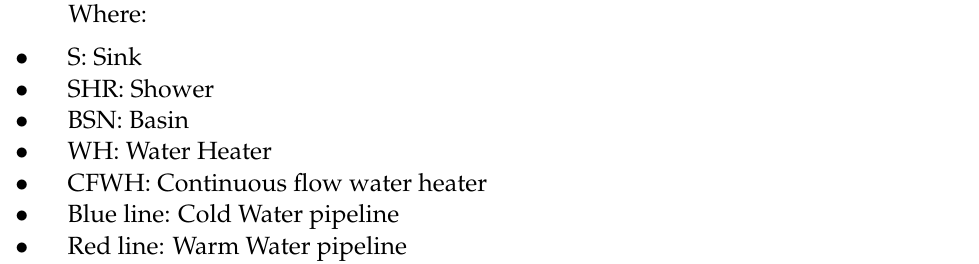
Figure 2. Example of a circulating warm water system controlled by a continuous flow water heater.